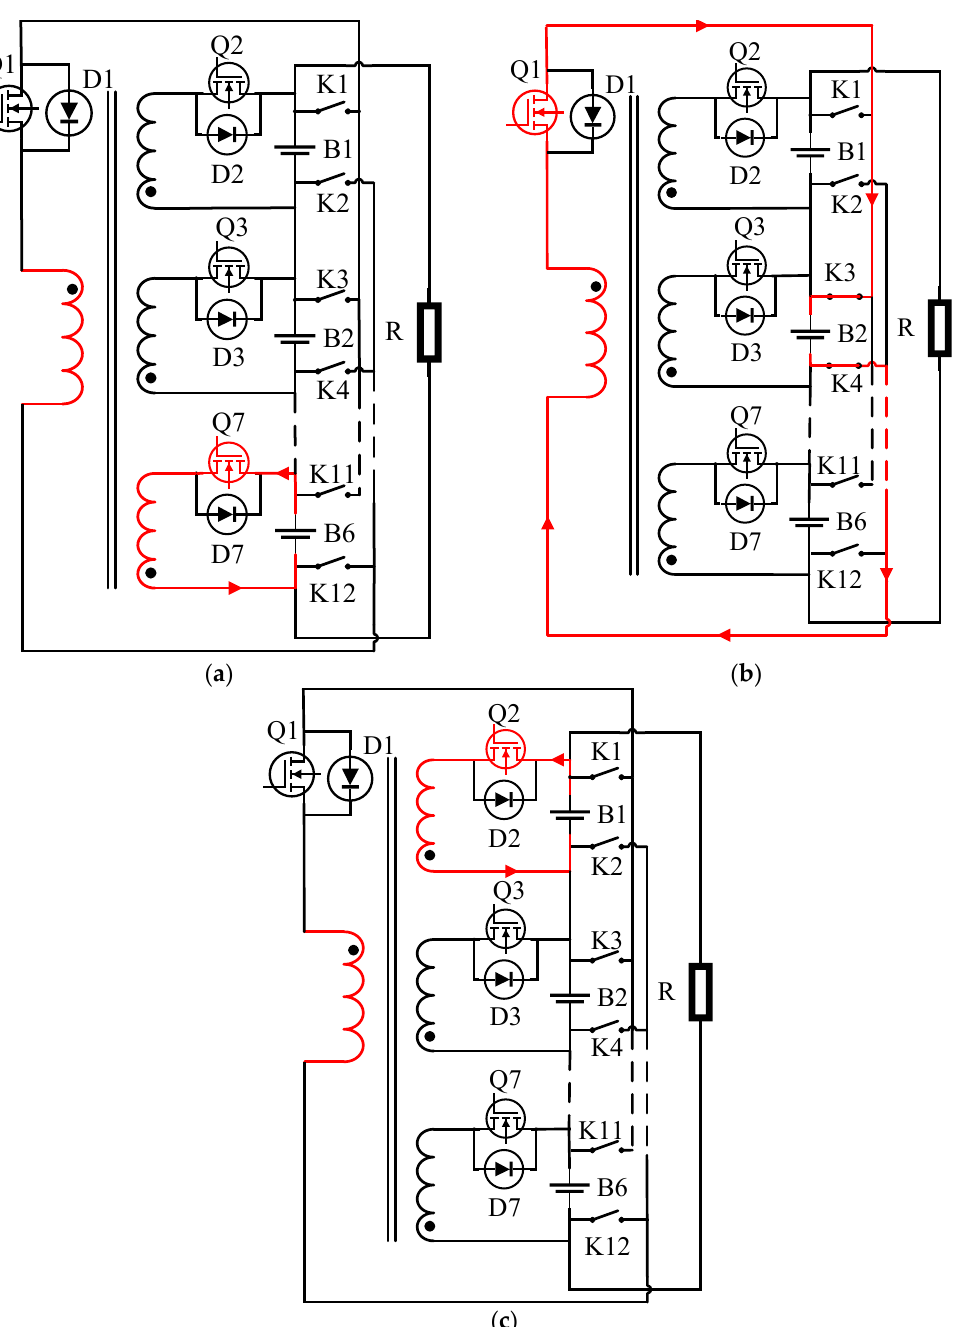
Figure 5. Working process of equalization mode 2. ( a ) Battery B6 discharges to primary winding. ( b ) Primary winding discharges to battery B2. ( c ) Battery B1 discharges to the primary winding. 3. Equilibrium mode 3: this mode is suitable for energy transfer from multi-cell high-